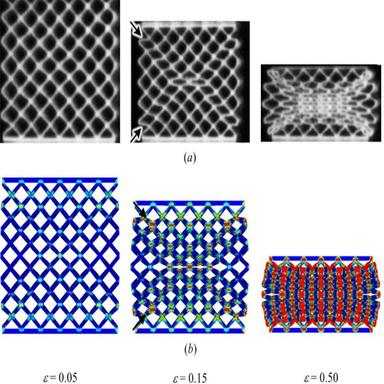
Comparison between deformation patterns derived from (a) the experiment in (; (b) finite element modelling by this work. (ε is nominal strain).